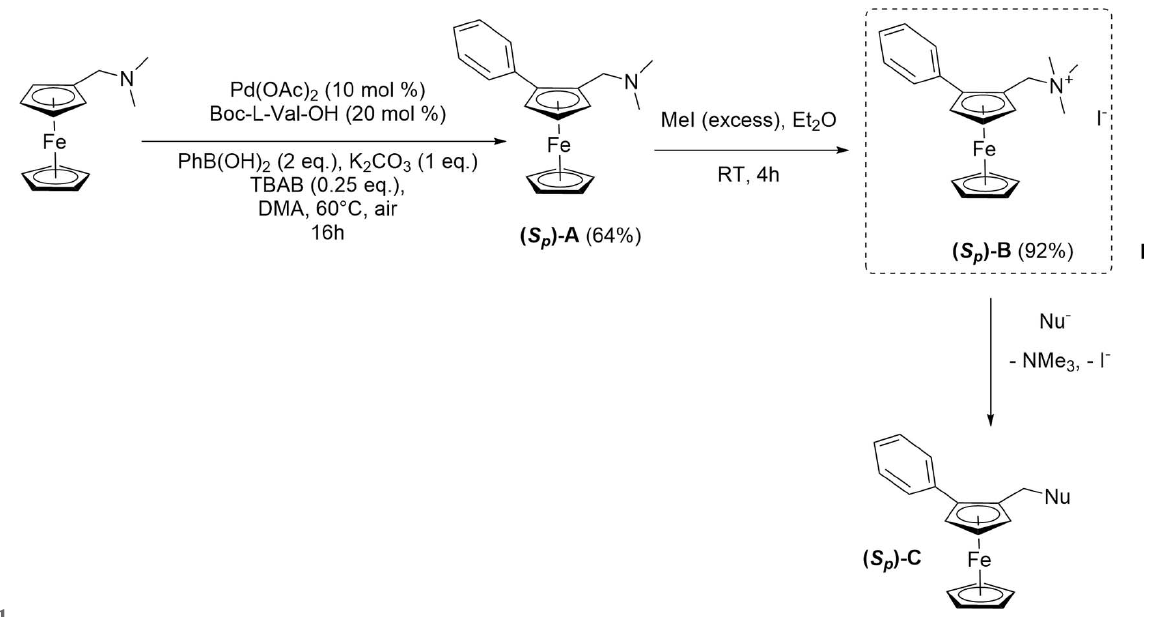
Figure 1 Synthesis of the title ( S p )-1-dimethylaminomethyl-2-phenylferrocenium iodide